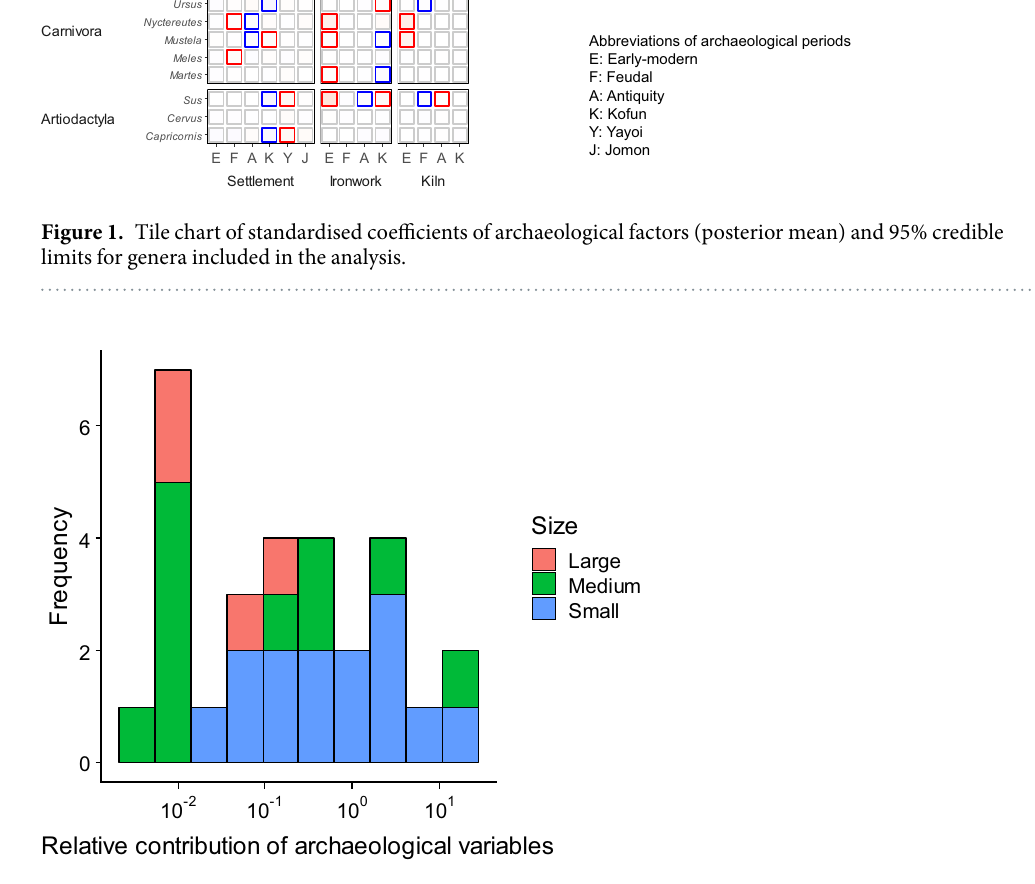
Figure 2. Summary of relative importance of archaeological factors 24 in relation to body